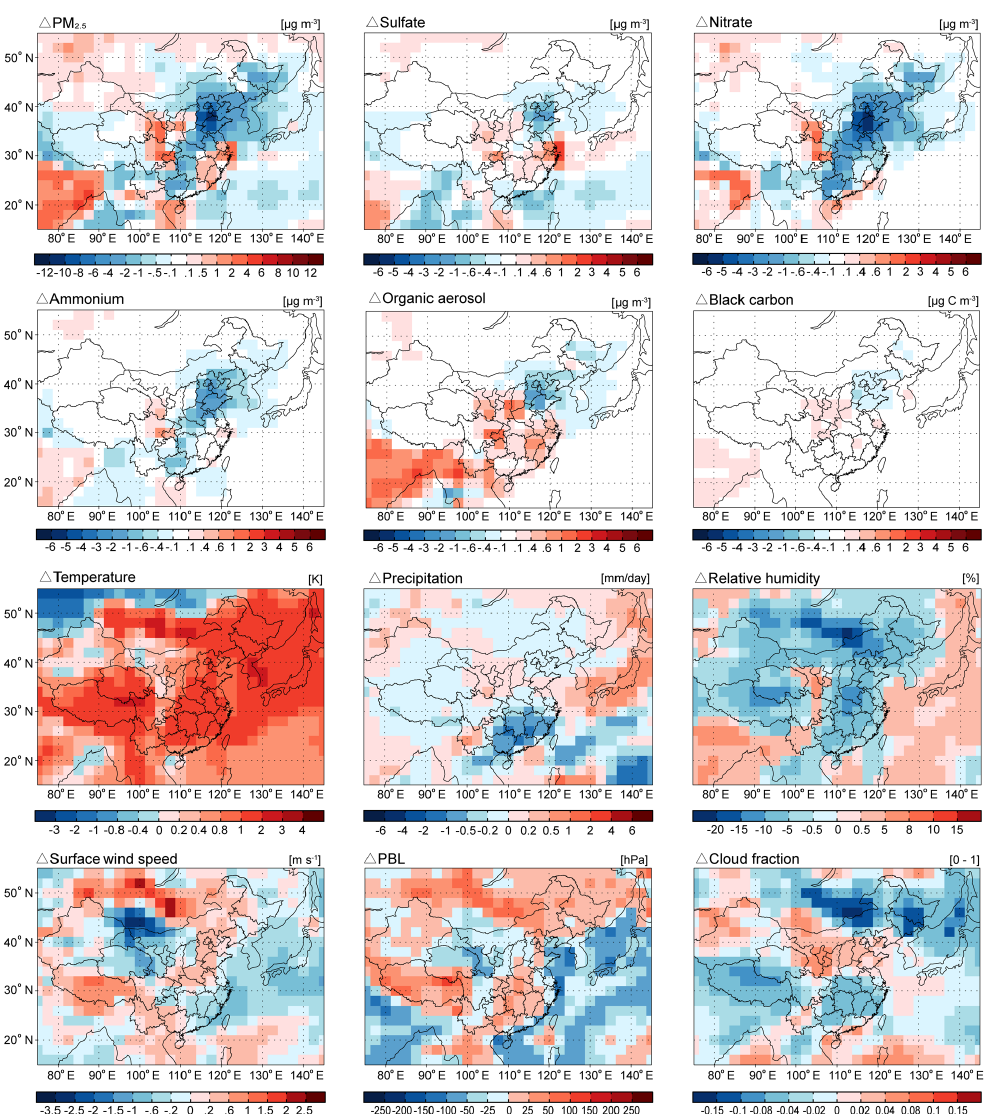
Figure 4. Simulated changes of wintertime (DJF) surface concentrations for PM 2 . 5 , sulfate, nitrate, ammonium, organic aerosol, black carbon, surface temperature, total precipitation at the ground, relative humidity, surface wind speed, planetary boundary layer depth (PBL), and cloud fraction in East Asia arising from 1980–2010 changes in climate alone ([ CTRL ] – [ S_CLIM